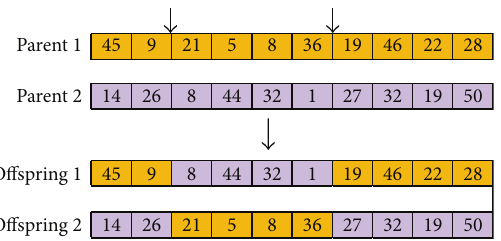
Figure 7: An illustration of 2-point crossover.